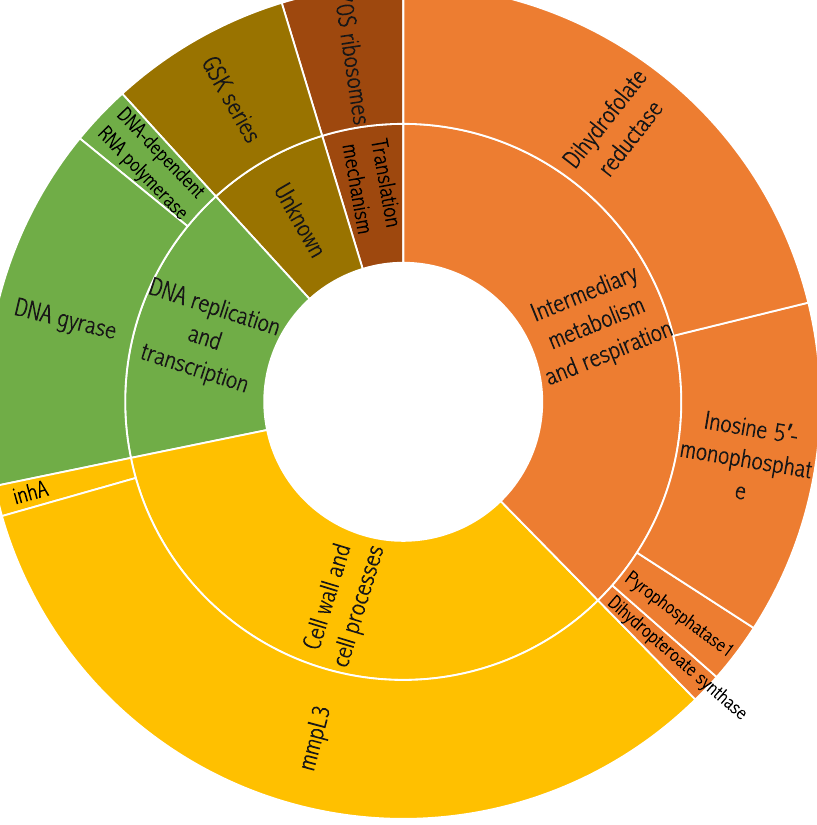
Figure 1. Clustering analysis of the modes of action (MOAs) from 85 compounds. Rationalizing that it would be difficult to obtain mutants for intracellular Mtb , we mimicked the intracellular environment within the macrophages by performing in vitro MIC in various carbon sources; the 85 hit compounds selected were subject to in vitro MIC in different carbon sources (glucose, cholesterol, and acetate) of which 27 (34%)